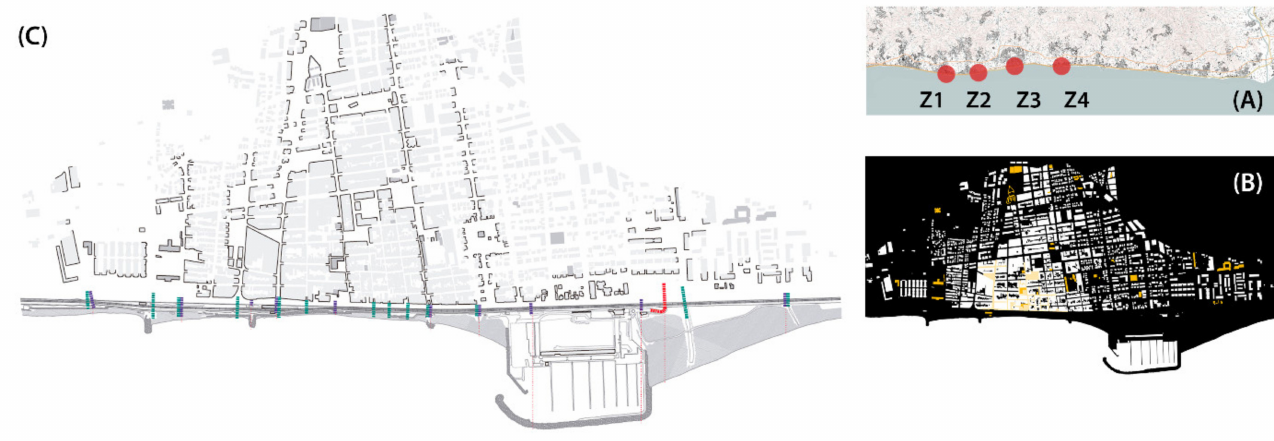
Figure 8. Graphics of the first approaches from urban regeneration projects (Source: authors’ own). ( A ) Location of case studies in the Maresme region. ( B ) Figure and ground diagram of Premi à de Mar, with urban structure, public spaces and buildings related to the coastline. ( C ) Transversal street and underground passage catalogue of Premi à de